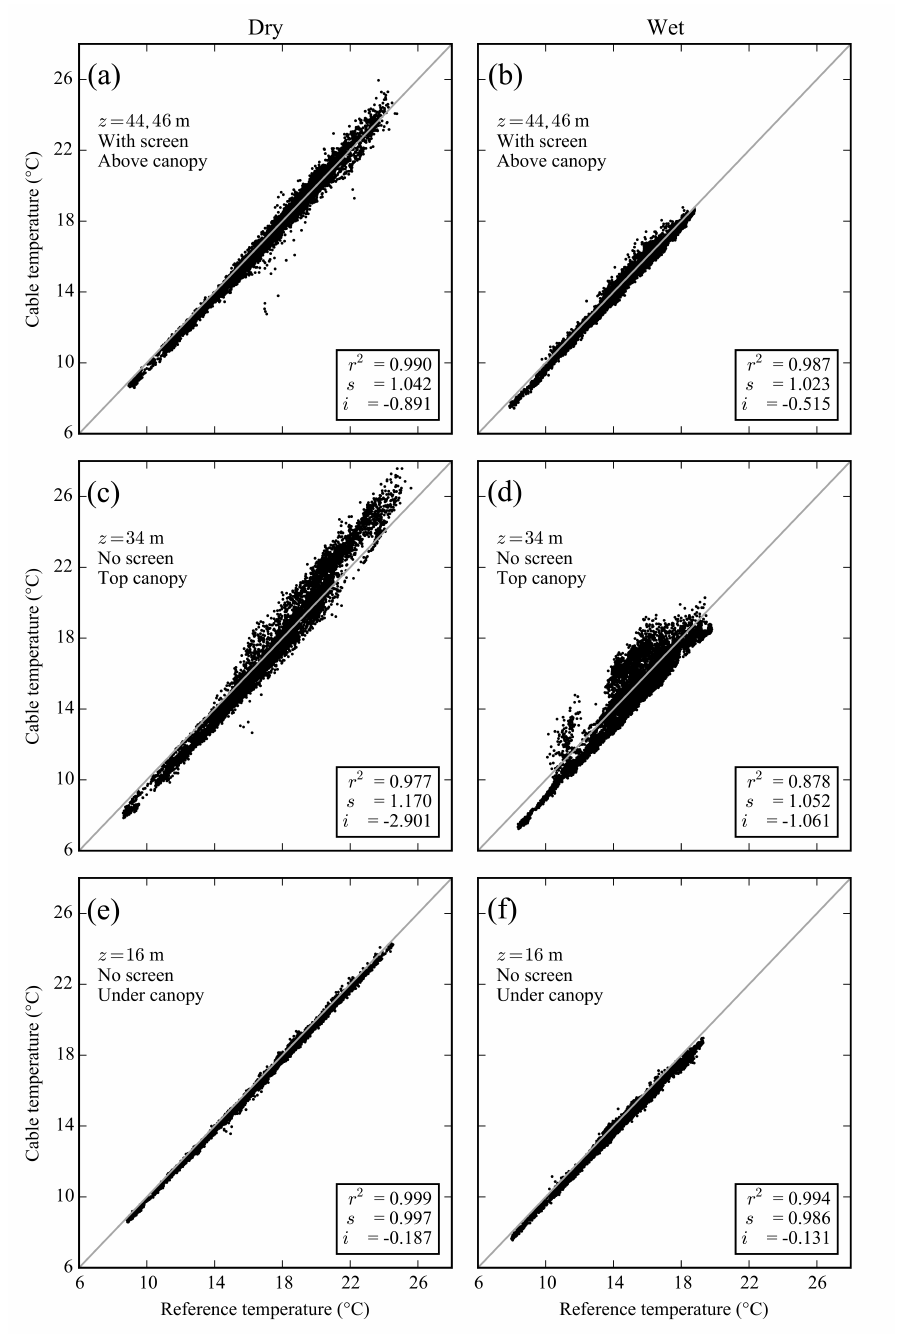
Figure 5. Comparison between the 6mm DTS cable and reference temperatures. Grey line shows 1:1 correlation. Data from 10–23 Au- gust 2016. (a) Dry cable at 44m and reference air temperature at 46m; the cable is shielded by the screen. (b) Wet cable at 44m and reference wet-bulb temperature at 46m; the cable is shielded by the screen. (c) Dry cable and reference air temperature at 34m; the cable is exposed to direct sunlight. (d) Wet cable and reference wet-bulb temperature at 34m; the fibre optic cable is exposed to direct sunlight. (e) Dry cable and reference air temperature at 16m, under the canopy so less direct sunlight hits the fibre optic cable. (f) Wet cable and reference wet-bulb temperature at 16m, under the canopy so less direct sunlight hits the fibre optic cable. Shown are the linear correlation coefficients: the coefficient of determination ( r 2 ), the slope ( s ) and the intercept ( i